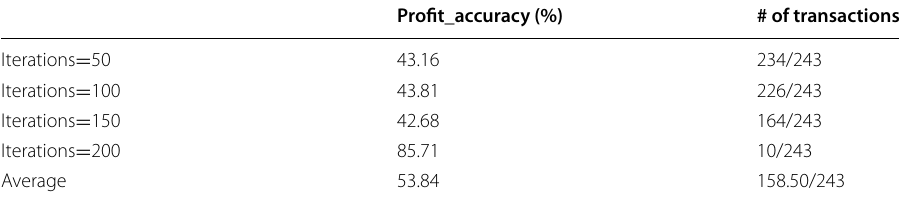
Profit_accuracy (%)